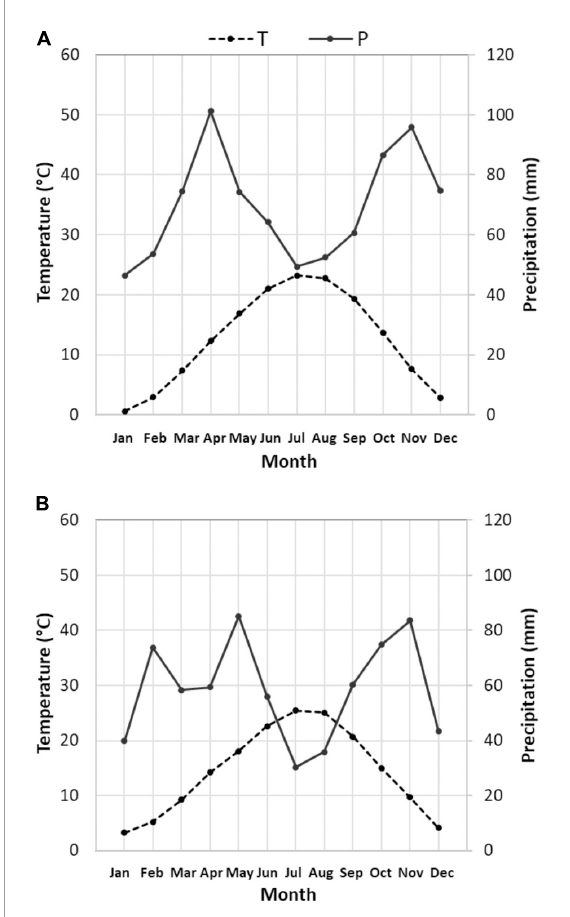
FIGURE2 Climatic characterization (Bagnouls–Gaussen diagram) for past (A) and present (B) period: diagrams are both based on 15 years averaged data, gathered by Corticella-Cadriano continuous and uniform daily mechanical weather data historical series, representative of the Bolognese Plain. Please note that in the Bagnouls and Gaussen representation, the precipitation (P) axis doubles the temperature (T) axis. In this condition, the aridity period is defined as that during which the precipitation line is below the temperature